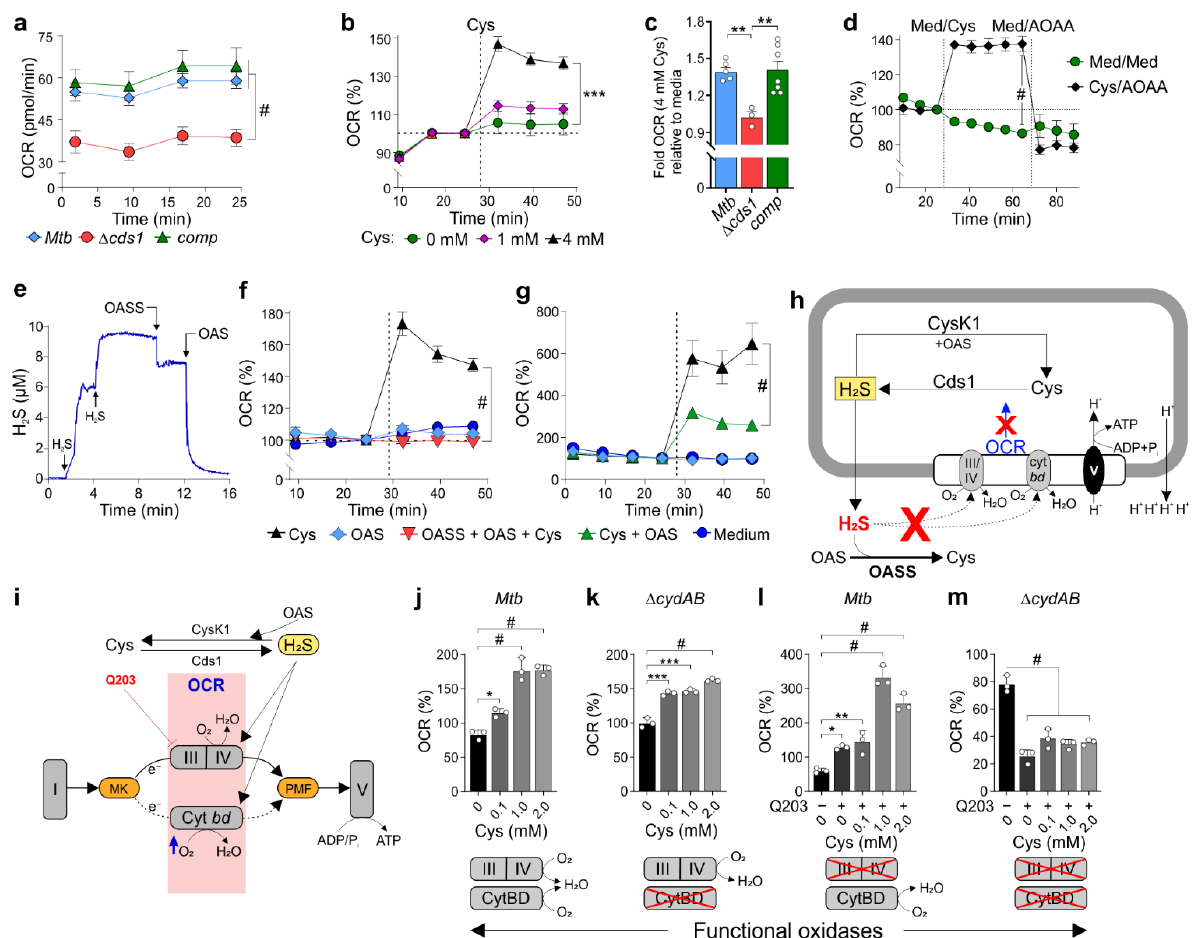
Figure 5. Endogenous H 2 S stimulates respiration in Mtb . Mtb respiration was measured using an Agilent Seahorse